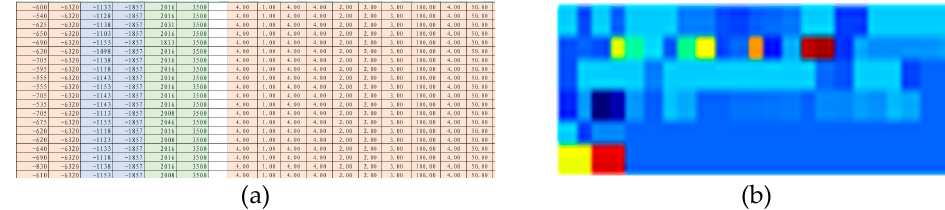
Figure 1. Pre ‐ experiment results. ( a ) simulation pre ‐ experiment results (part); ( b ) heatmap of char ‐ Figure 1. Pre-experiment results. ( a ) simulation pre-experiment results (part); ( b ) heatmap of acter choice. character